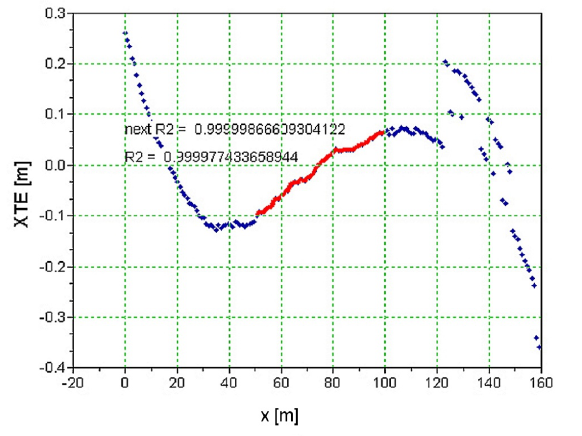
Figure 8: Separated straight section in local coordinate